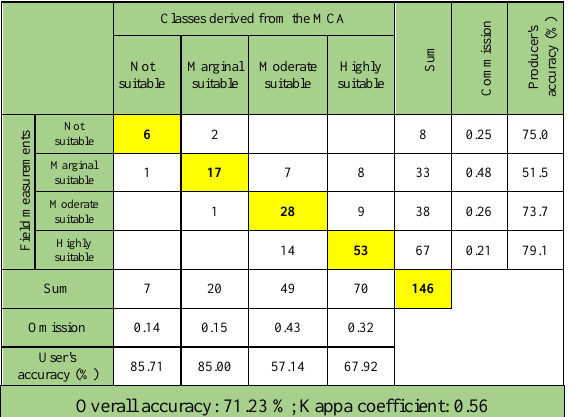
Table 7. Confusion matrix and accuracy estimates for the cropland suitability map.